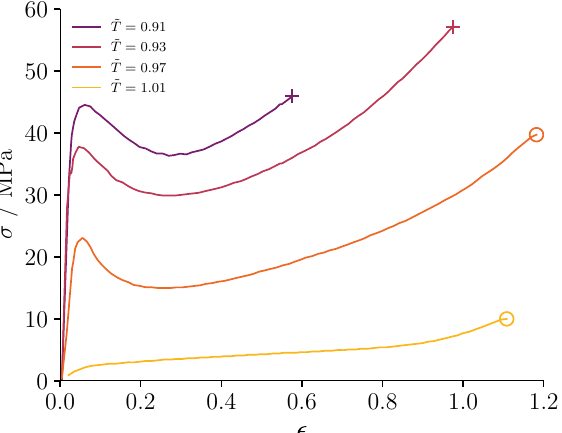
Figure 1. Uniaxial stress σ vs strain ε in PMMA under tension loading (digitized from 21 ): ductility increases with temperature while the whole rheology drastically changes across the glass transition regime 21 . The plus symbol at the of the curves represents final fracture propagation, while the open dots implies that no final fracturing